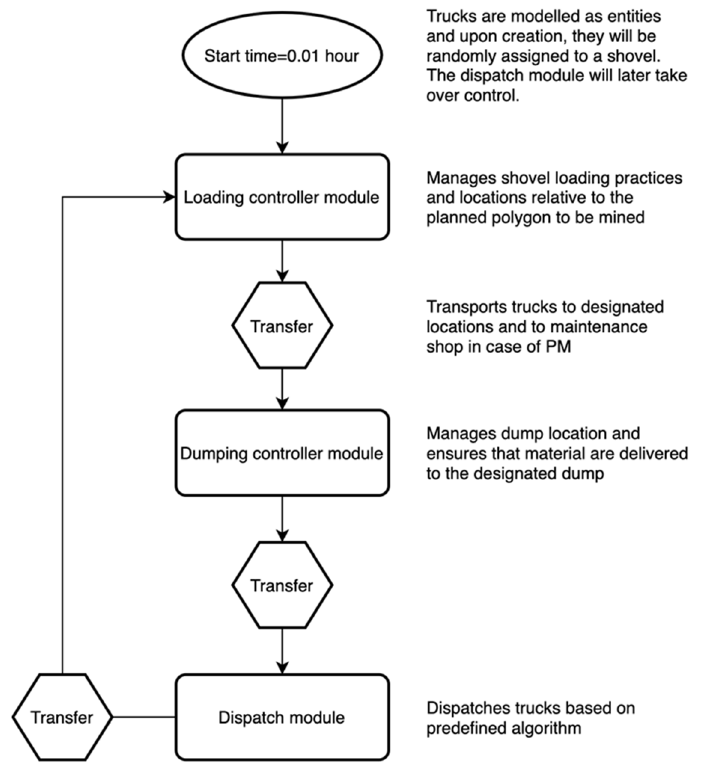
Figure 1. Flow of the mine operation